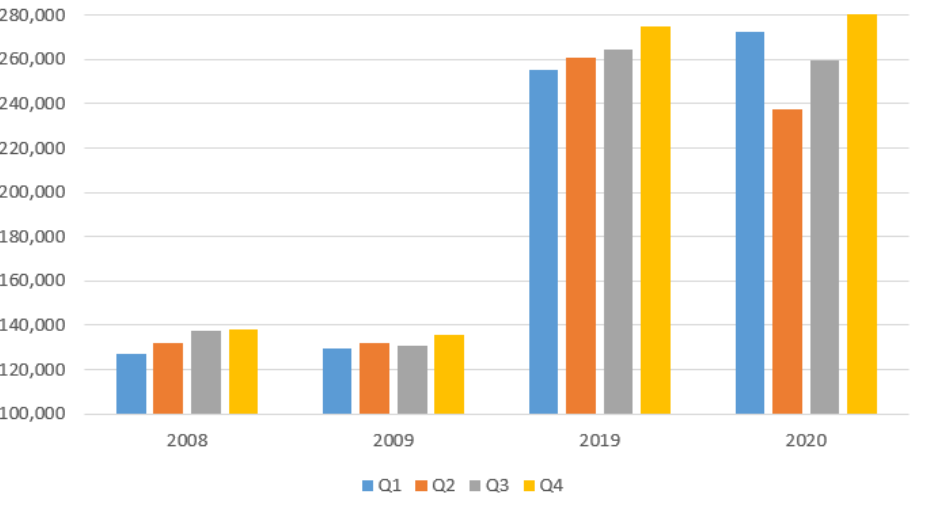
Table 1. Analysis of the average annual and quarterly rate (AGR) and the graph of the evolution of the indicators in the period 2007–2020.